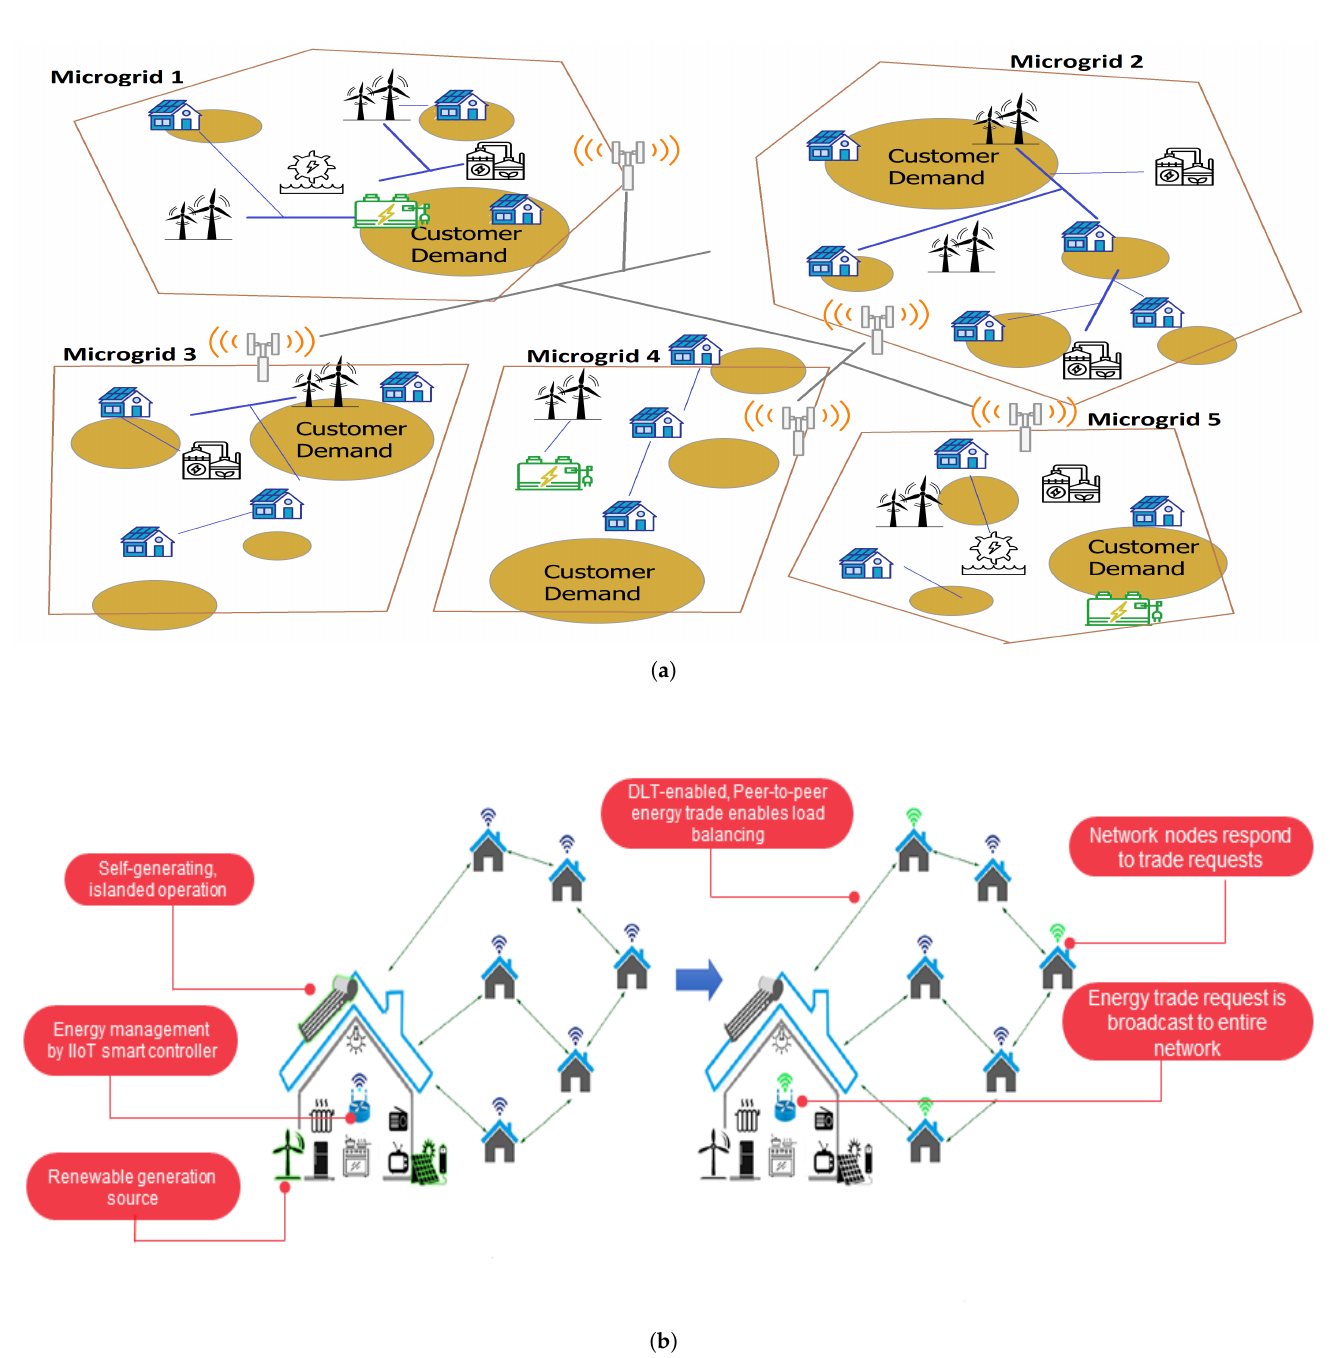
Figure 4. The distributed ledger technologies (DLT)-enabled microgrid community. ( a ) Proposed microgrid architecture for rural network deployments [36]; ( b ) Operation of the DLT-IIoT microgrid can be broken into two main stages: isolated, self generation and DLT-enabled energy trading (adapted from [17], ©2020